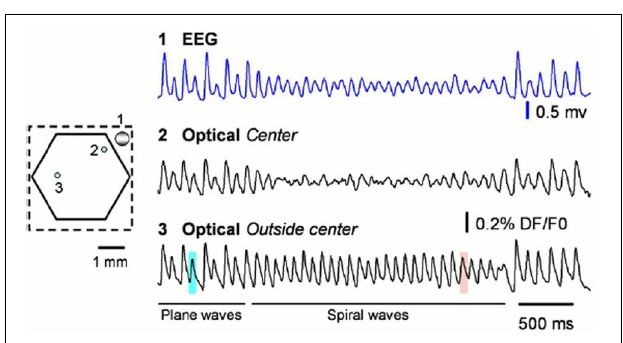
FIGURE 9 | From the original; raw data traces from the EEG (blue) and two optical detectors labeled on the left. Detector 2 (Optical spiral center) is selected from the spiral center, showing large amplitude reduction. Detector 3 is selected from a location that spiral center never swept through, showing no amplitude reduction. From Huang et al. (2010), copyright Elsevier